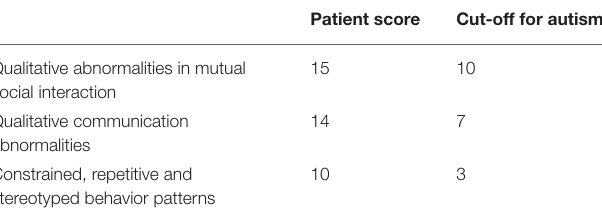
TABLE 1 | The results of semi-structured interview